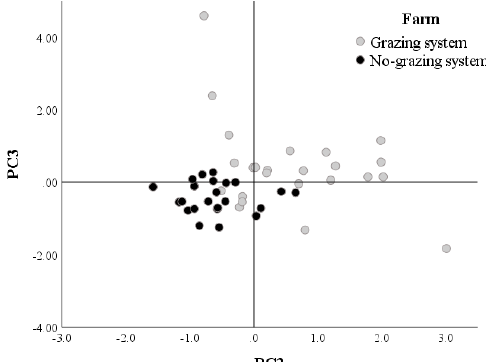
Figure 4. Factor maps of the principal component analysis (PCA). Distributions of the scores concerning the PC2. C18 PUFA & C15 ( x -axis) and PC3. C > 18 & CLA ( y -axis) extracted after PCA. The